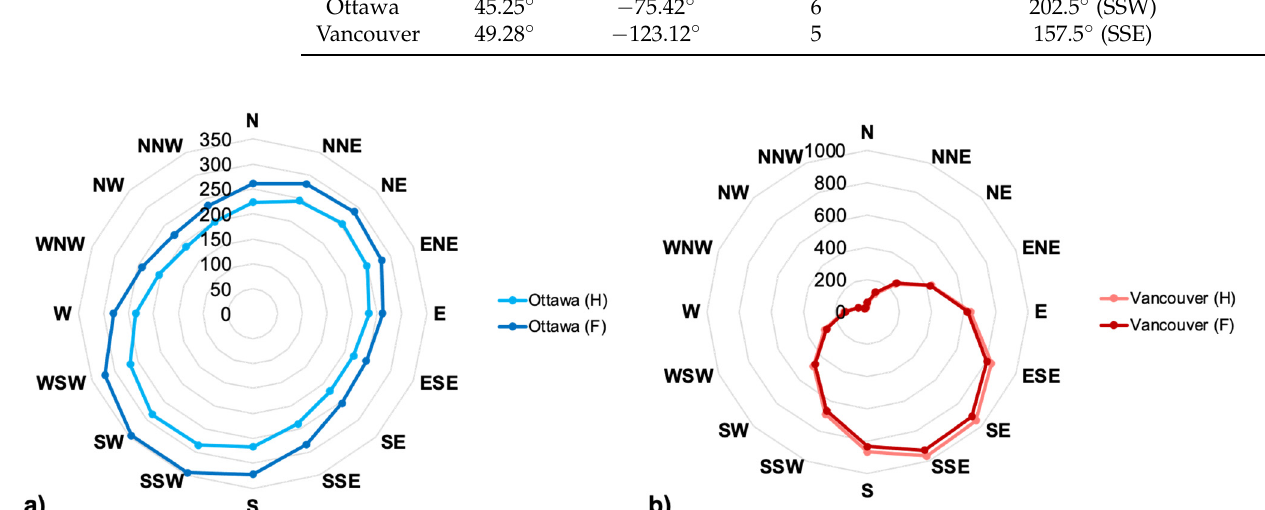
Figure 2. Comparison of ( a ) annual average temperature, ( b ) annual average relative humidity, and ( c ) annual rainfall, during the time periods of 1989–2016 (H) and 2062–2092 (F) in Ottawa and Vancouver.